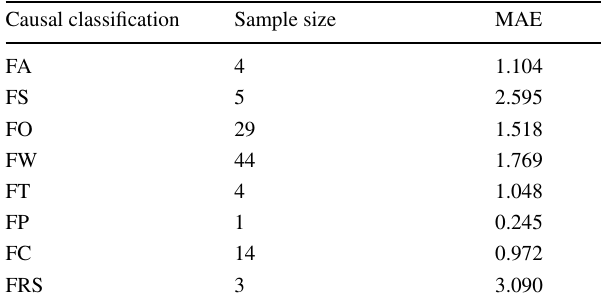
Fig. 15 Model prediction accuracy for different initial delay